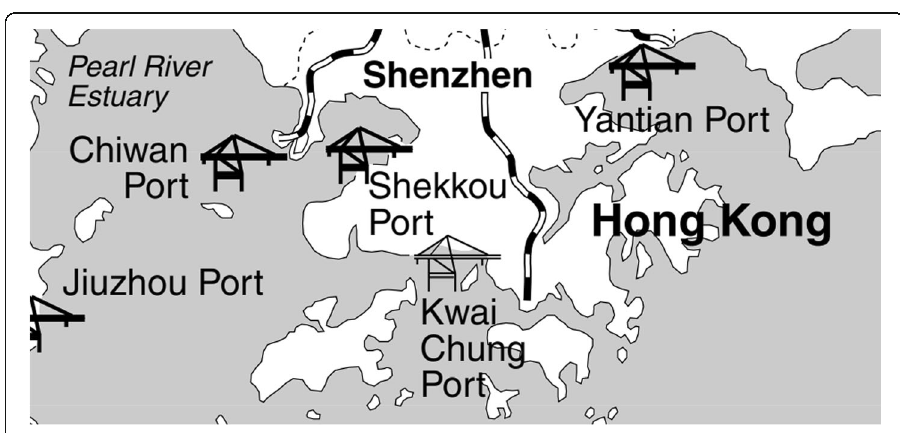
Fig. 2 Port map of Hong Kong and Shenzhen. Source: Research in transportation economics 2018; Adapted from Song